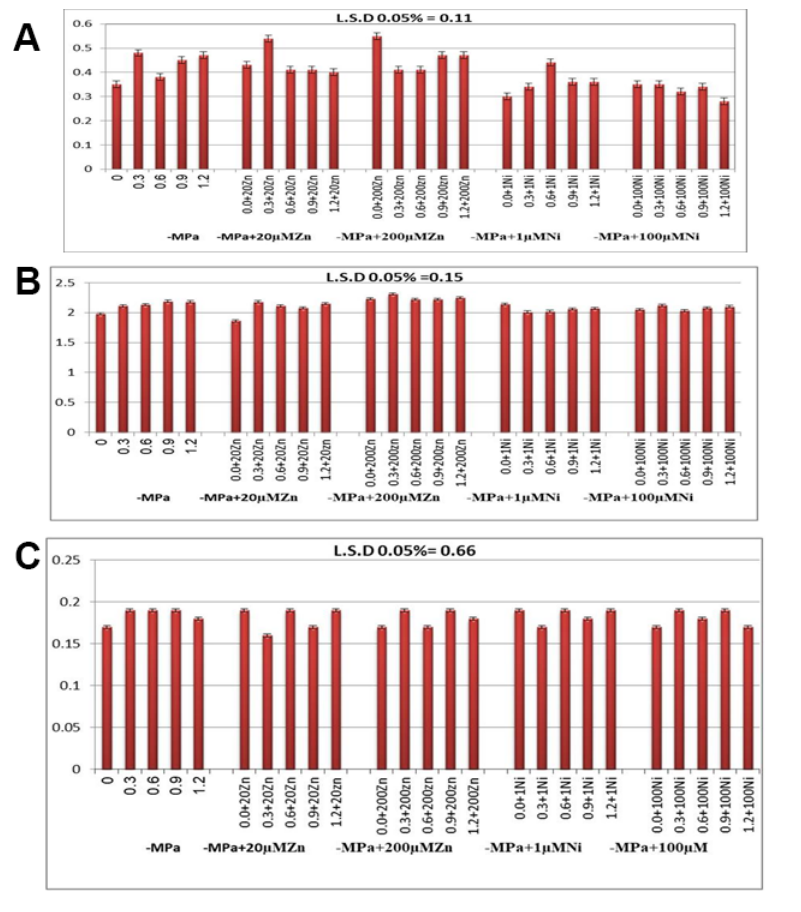
Figure 2 Anthocyanin ( A ), -ascorbic acid ( B ), and flavonoid ( C ) concentrations (mg/g dry matter) in wheat treated by different NaCl-induced osmotic stress levels with or without Zn (20 and 200 μM) or Ni (1 and 100 μM)